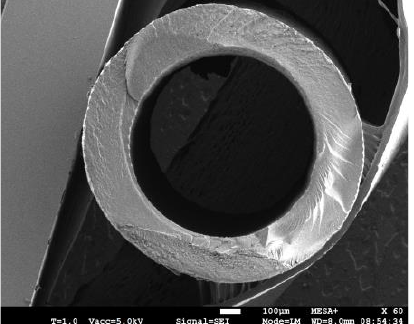
Figure 5. SEM photographs of the tube with a diameter of 900 µm, and a wall thickness of 230 µm. Based on the resolution of the printer that we used, this is the thinnest wall that could be reached for this U-shaped tube. A thinner wall caused leakage and a thicker wall decreased the sensitivity of the sensor due to the increased mass of the tube.